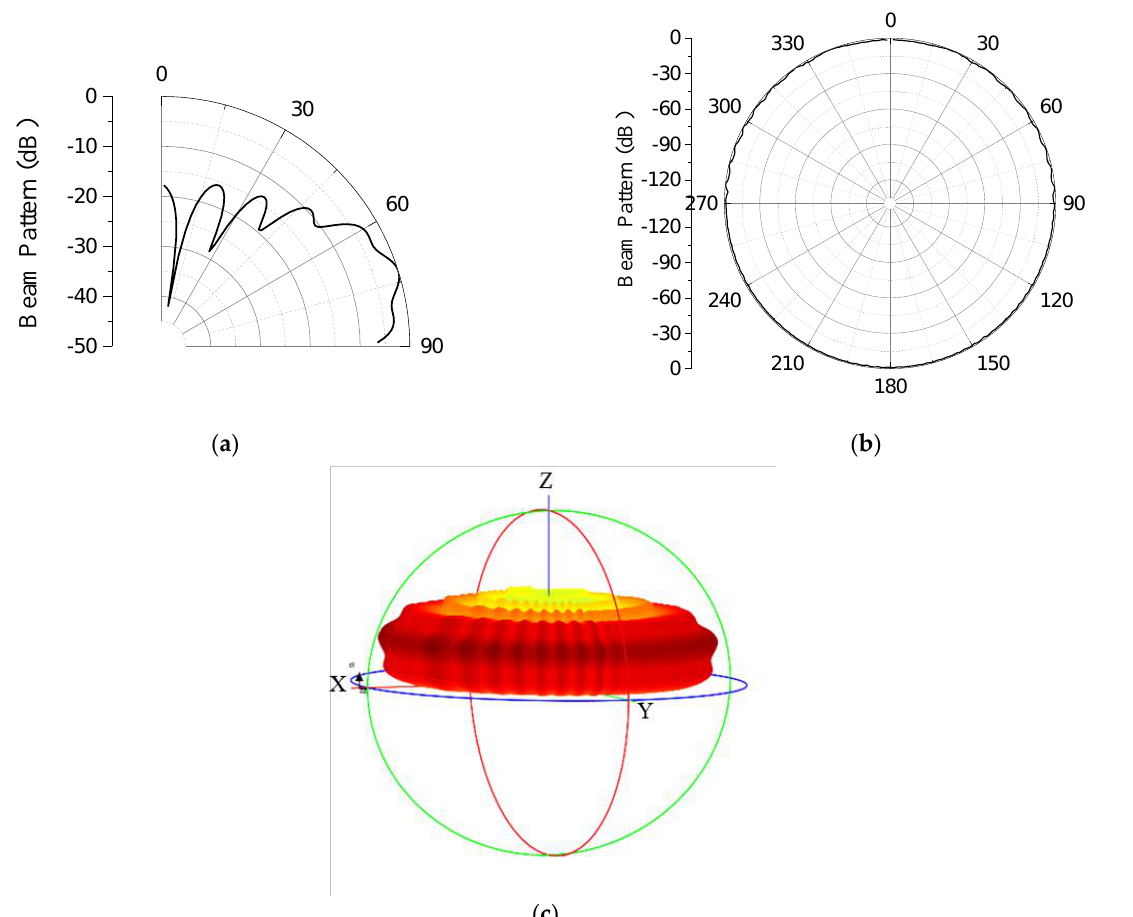
Figure 11. Beam patterns of the SA on: ( a ) elevation plane; ( b ) azimuth plane; and ( c ) three−dimen- Beam patterns of the SA on: ( a ) elevation plane; ( b ) azimuth plane; and sional space. ( c ) three − dimensional space.